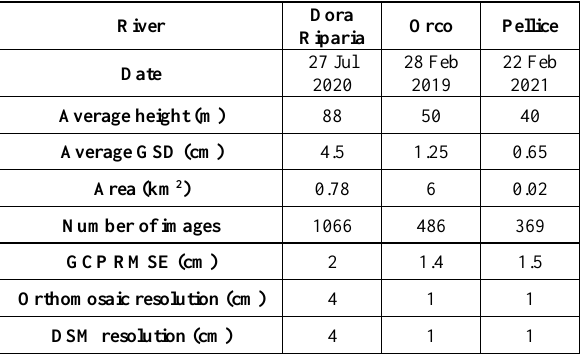
Table 3. Characteristics of the UAV campaign over the test